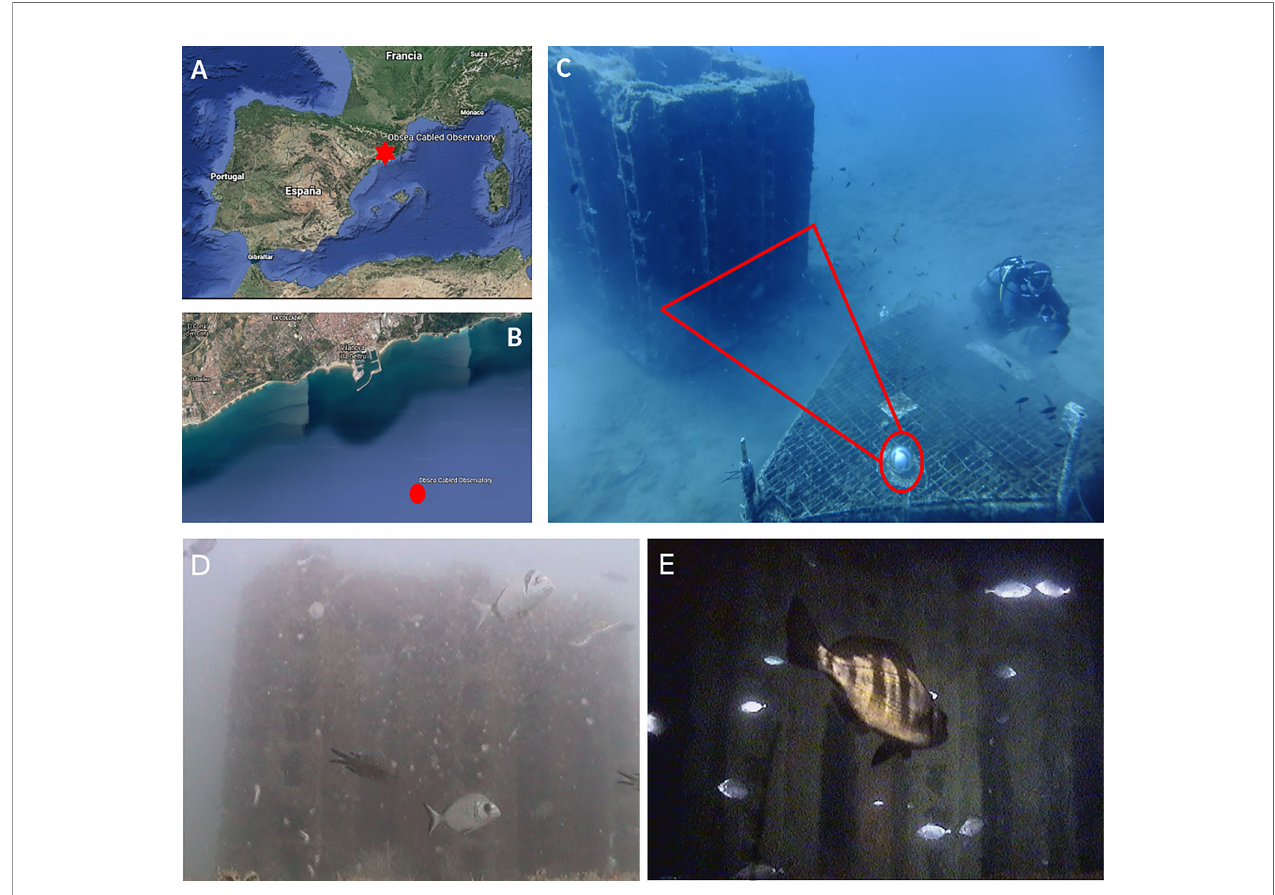
FIGURE 1 | The location of the OBSEA observatory in the Mediterranean Sea (A, B) ; The fi eld of view of the camera installed in the observatory (C) ; Two examples of images acquired by the OBSEA camera, during the daylight (D) and during the night (E) , using the arti fi cial lighting system of the